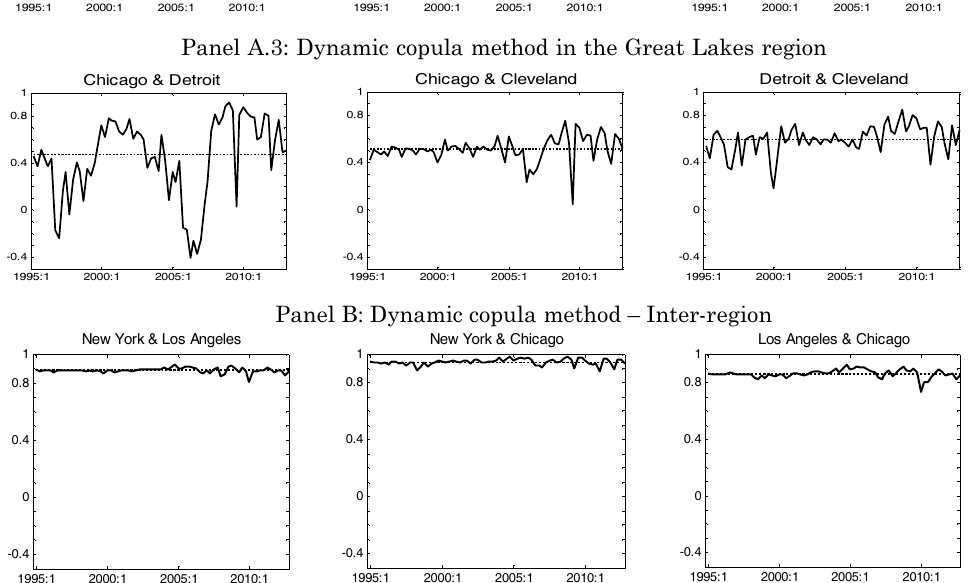
Note : This figure presents the Pearson static correlation (dotted line) and Copula time-varying dynamic correlation (solid line) in each pair of MSas. fig. 2. Pearson correlation and copula dynamic correlation in each